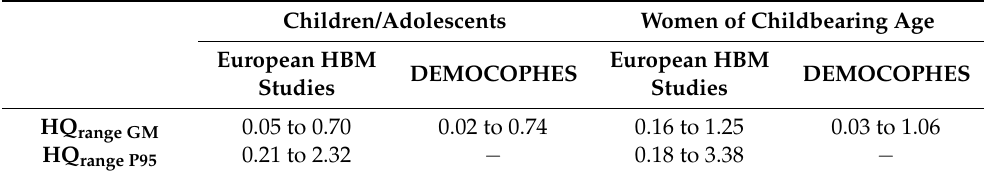
Table 3. HQ calculations for the GM and/or P95 of Hg levels in blood for all HBM studies considered for the selected populations.